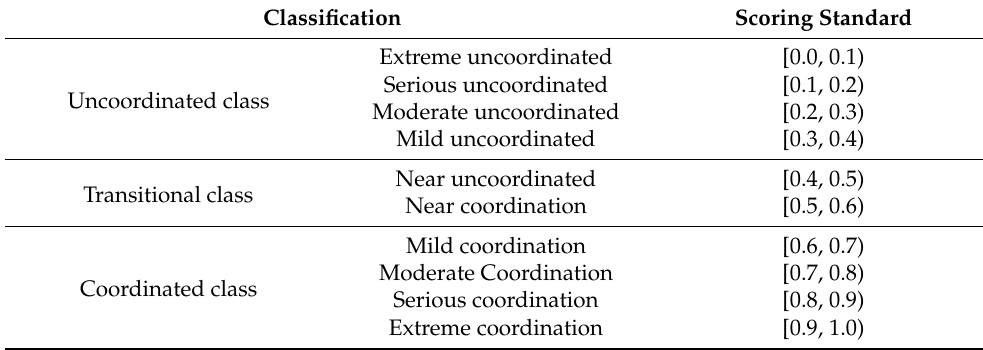
Table 4. Classification of PGS-SED coupling coordination degree